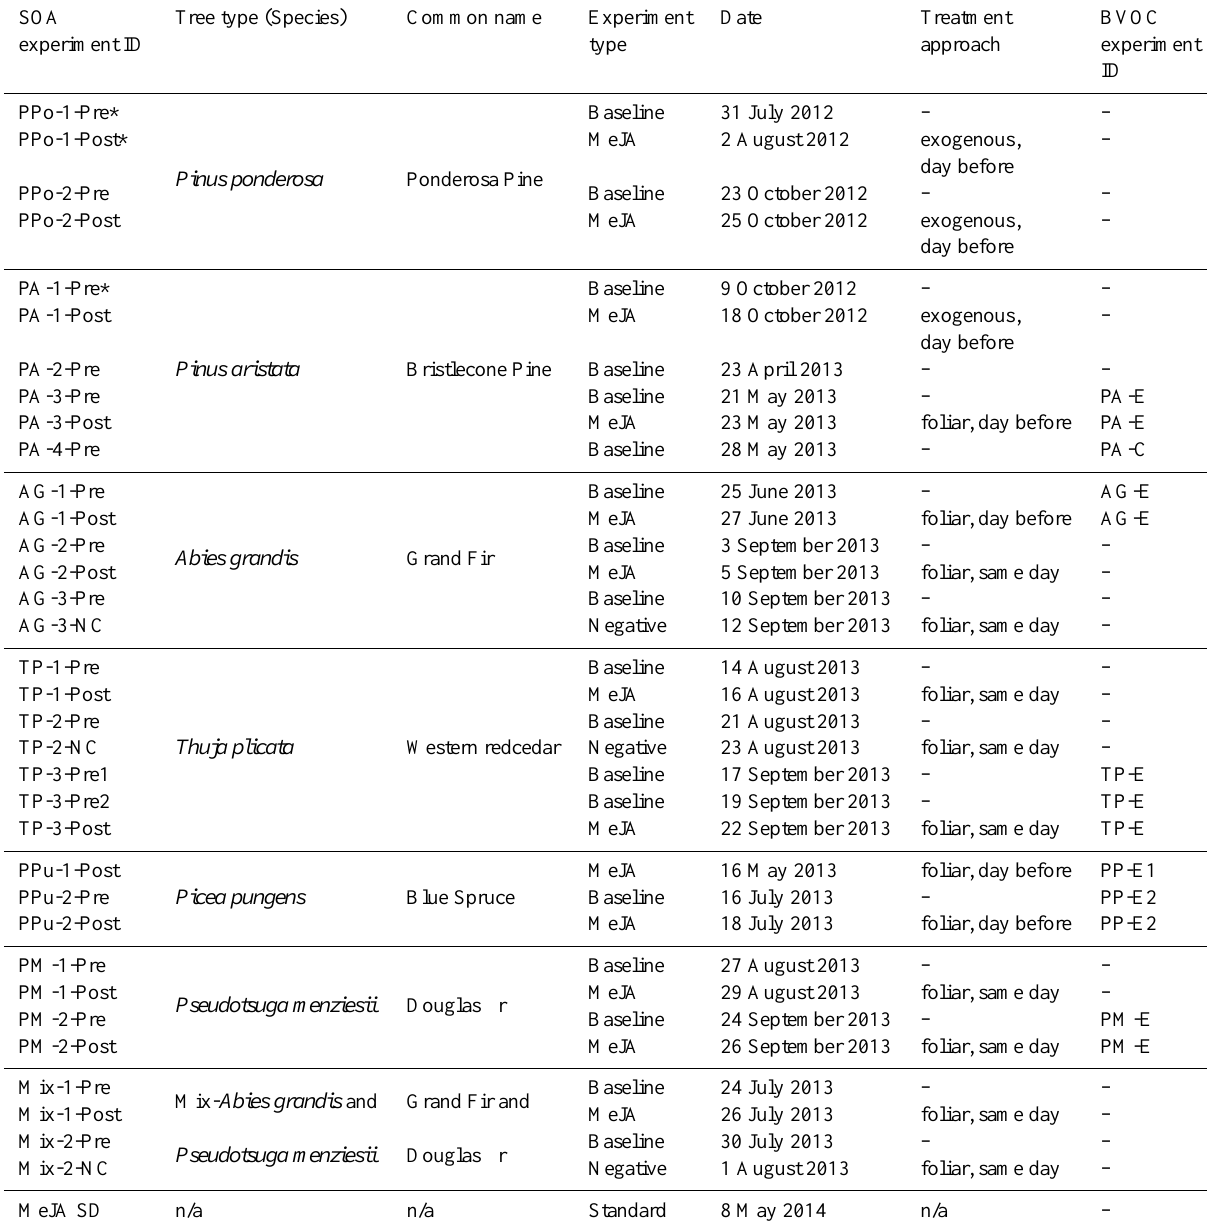
Table 1. Experiment summary. Asterisks on experiment ID indicate that seed was used; MeJA is methyl jasmonate. The last column provides the IDs of the corresponding BVOC experiments, where available, to facilitate cross-referencing with the companion paper (Faiola et al., 2015). n/a means “not